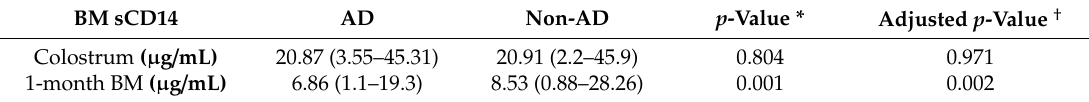
Table 2. Association of BM sCD14 with atopic dermatitis (AD) at 9 months of age. BM sCD14 AD Non-AD